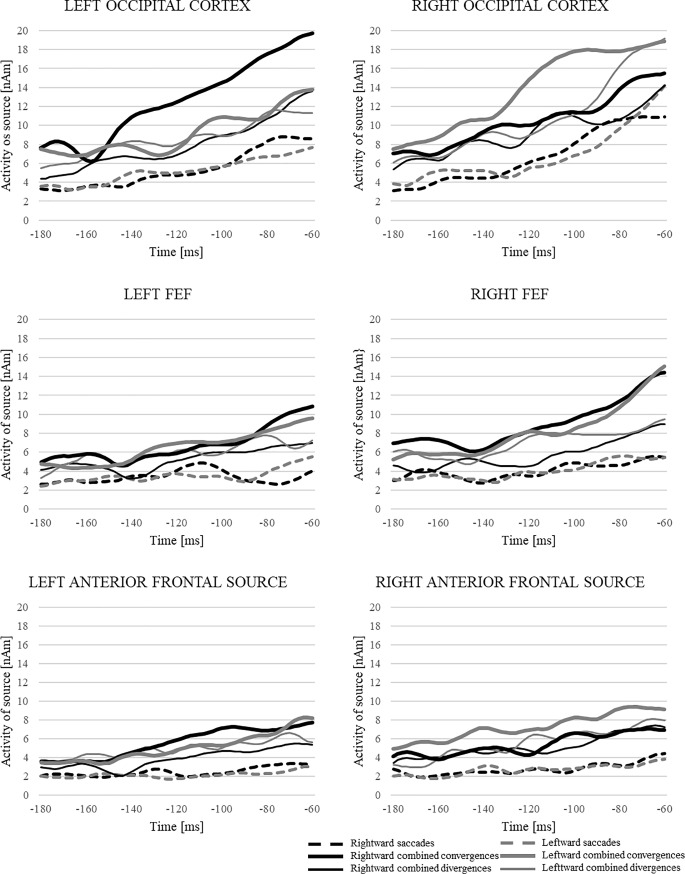
Source waveforms elicited by activity preceding the different eye movement types for each regional source.Source waveforms were prepared per participant by calculating the RMS (root mean square) for each condition within each of the three regional sources per hemisphere. Then, the averages of all individuals per condition were computed, the result of which is shown in the figure. The obtained individual averages for each type of eye movement per condition were used for statistical analyses.